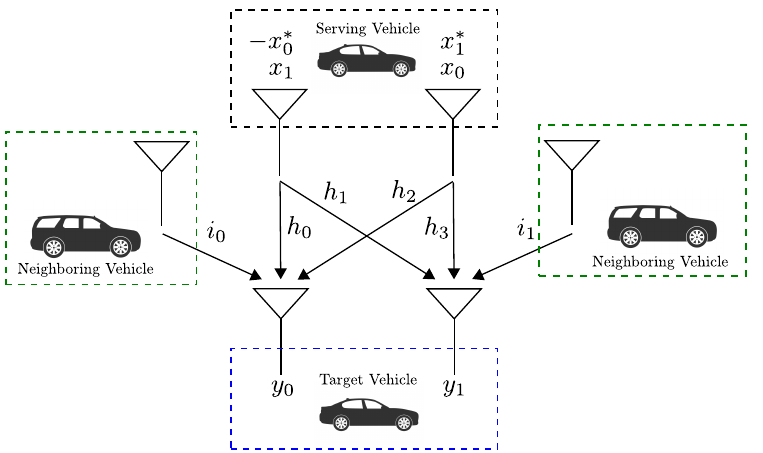
Figure 3. IRC-based WAVE receiver structure.